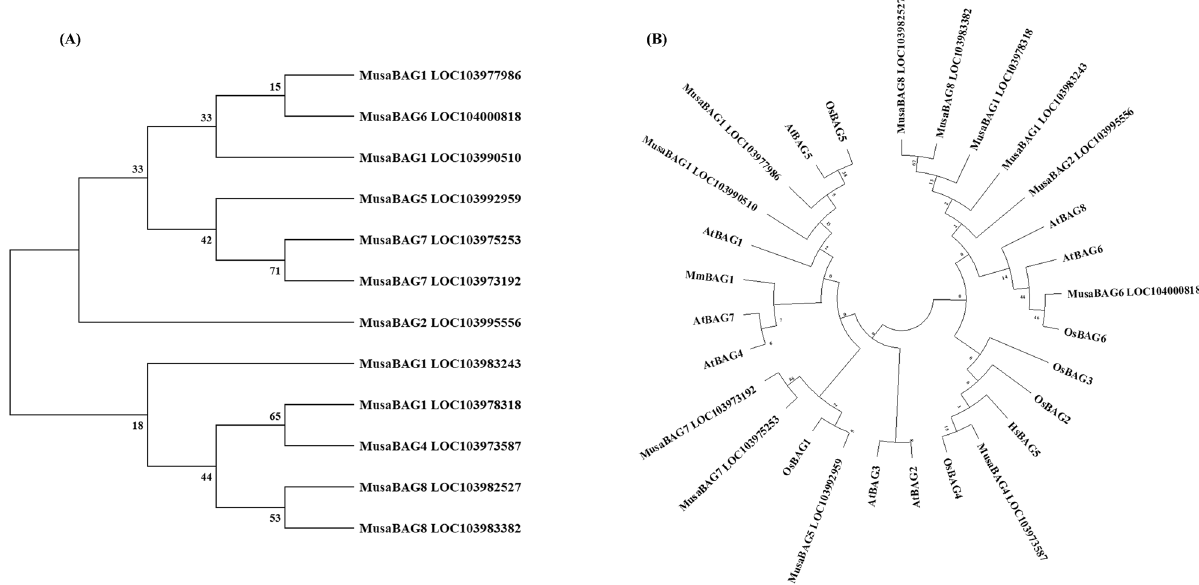
Figure 5. Phylogenetic analysis of the MusaBAG proteins. ( A ) The neighbor joining phylogenetic tree of the full length MusaBAG protein sequence (MusaBAG1_ LOC103983243: XM_009400456.2, MusaBAG1_LOC103990510: XM_009409679.2, MusaBAG1_LOC103977986: XM_009393675.2, MusaBAG1_LOC103978318: XM_009394078.2, MusaBAG2_LOC103995556: XM_018825077.1; MusaBAG4_LOC103973587: XM_009388204.2, MusaBAG5_LOC103992959: XM_009412890.2, MusaBAG6_LOC104000818: XM_009422955.2, MusaBAG7_LOC103975253: XM_009390167.2, MusaBAG7_LOC103973192: XM_009387694.2, MusaBAG8_LOC103982527: XM_009399476.2; MusaBAG8_ LOC103983382: XM_009400601.2) was constructed using MEGA version X, with 1000 bootstrap replications. The numbers marked near each branch indicates the percentage of replicate trees in which the associated taxa clustered together in the bootstrap test. ( B ) The neighbor joining phylogenetic tree constructed by taking BAG proteins of Arabidopsis (AtBAG1: NP_200019.2, AtBAG2: BAB10172.1, AtBAG3: NP_196339.1, AtBAG4: NP_190746.2, AtBAG5: NP_172670.2, AtBAG6: NP_182147.1, AtBAG7: NP_201045.1, AtBAG8: NP_189577.2), rice (OsBAG1: XP_015651322.1, OsBAG2: XP_015650279.1, OsBAG3: XP_015641134.1, OsBAG4: XP_015621585.1, OsBAG5: XP_015624985.1, OsBAG6: XP_015622983.1), banana (protein sequences same as in A ), mouse BAG1 (MmBAG1: Q60739.3) and human BAG5 (HsBAG5: NP_001015048.1). The tree was constructed using MEGA version X, with 1000 bootstrap replications. The numbers marked near each branch indicates the percentage of replicate trees in which the associated taxa clustered together in the bootstrap test.